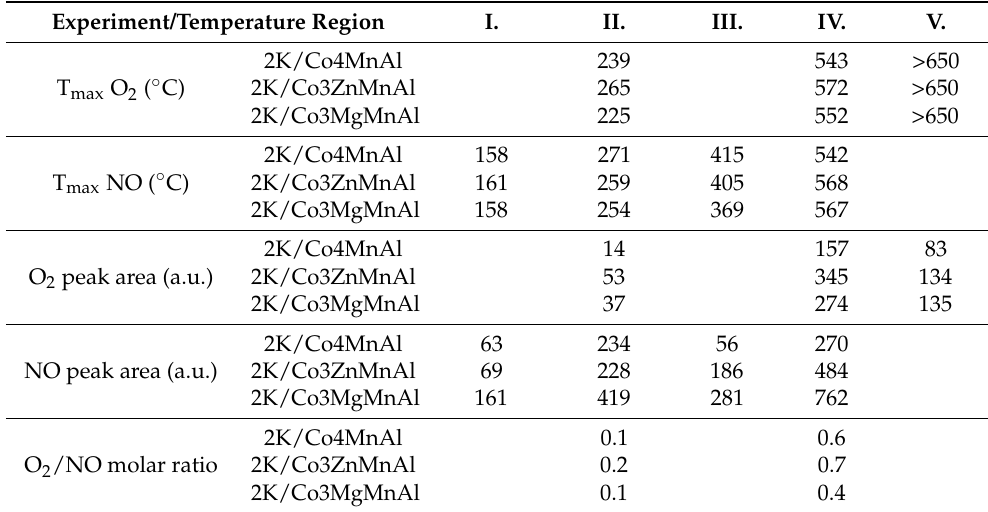
Table 7. The temperature maxima of the desorption of NO and O 2 and the peak areas obtained from the TPD-NO